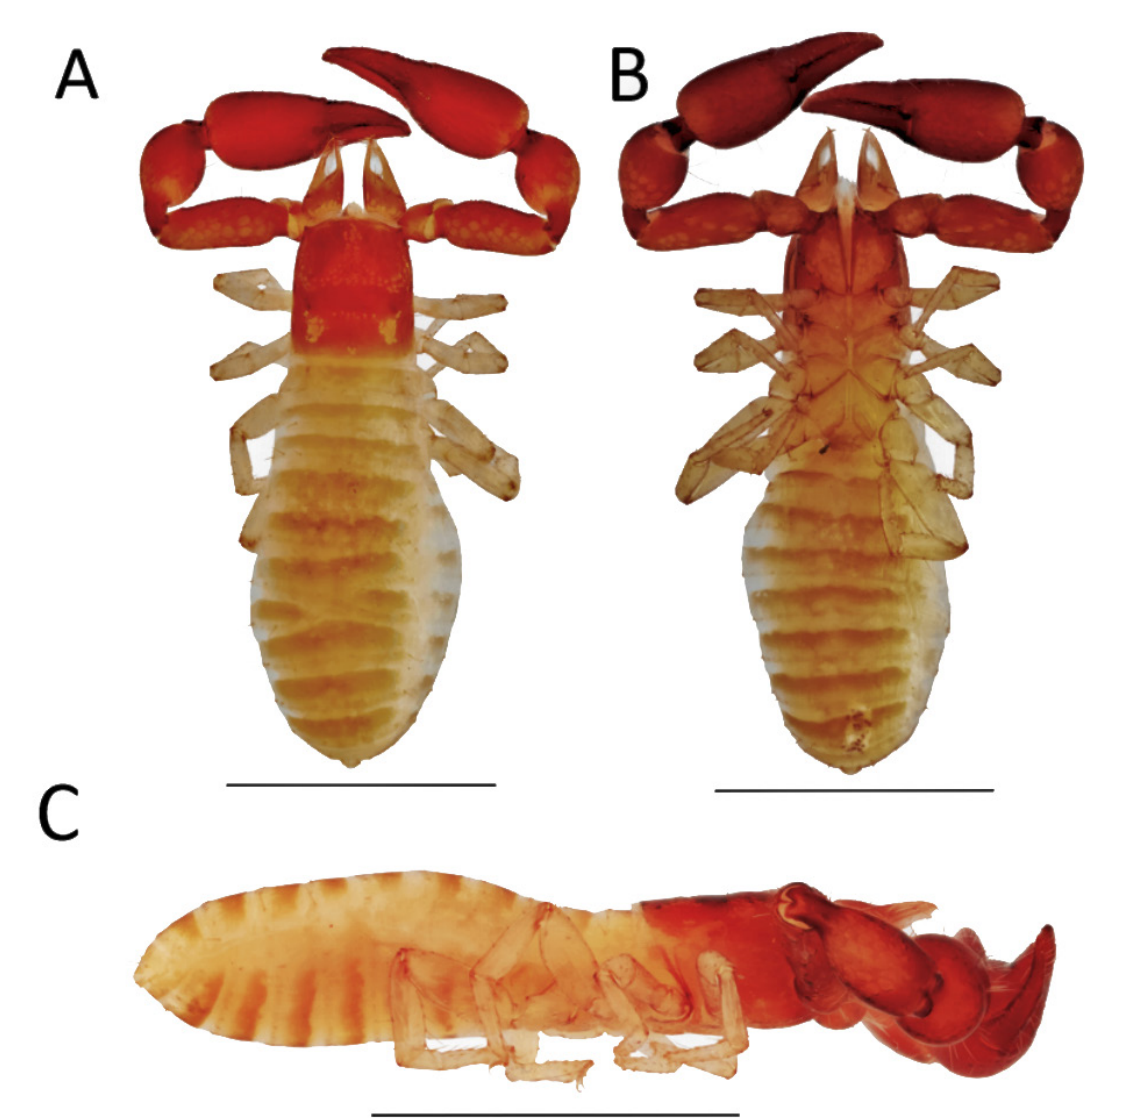
Fig. 25. Ideoblothrus safinai sp. nov., holotype, ♂ (QCAZ). A . Habitus in dorsal view. B . Habitus in ventral view. C . Habitus in lateral view. Scale bars = 1